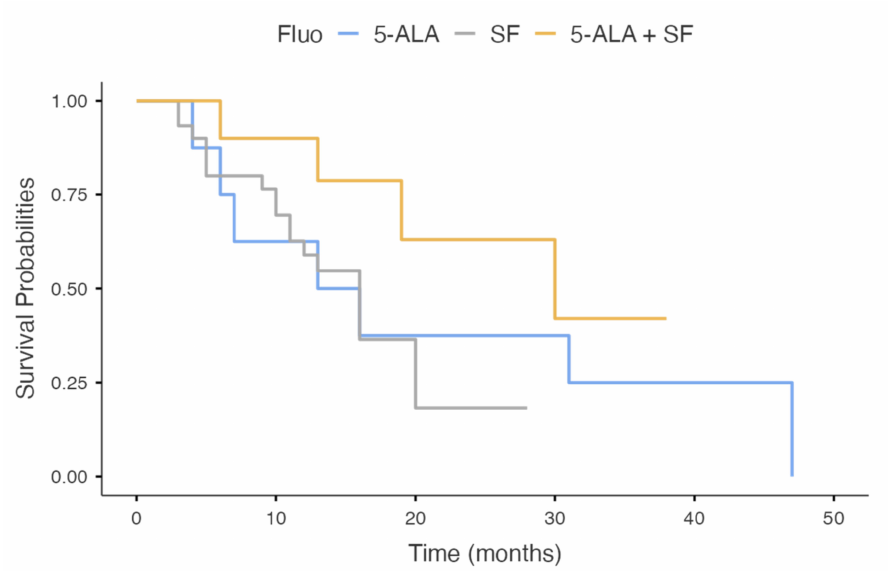
Figure 2. Kaplan–Meier survival analysis of OS stratified for different fluorophores. There is not a statistically significative advantage in terms of OS. A slight advantage might be present in the contemporary use of both fluorophores (yellow line).